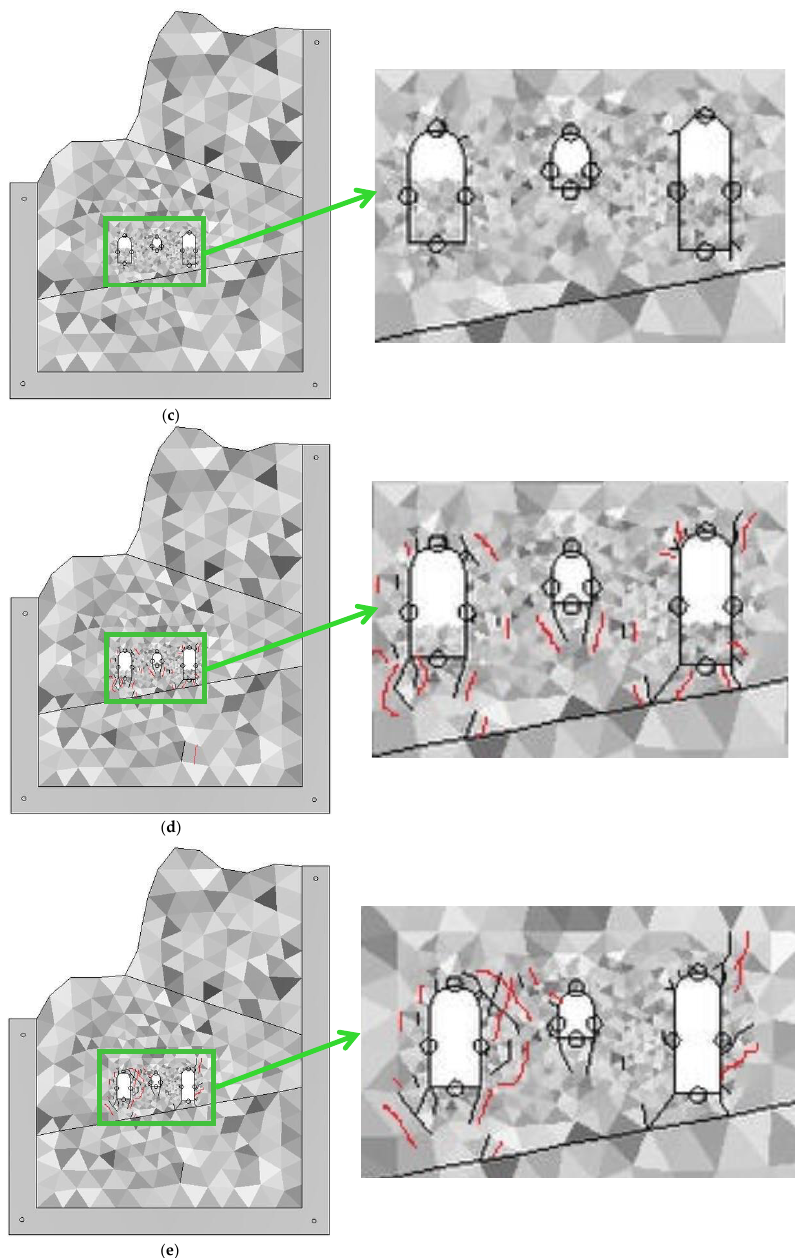
Figure 6. Failure process of SR of the underground cavern group during excavation in Scheme 2: ( a ) The excavation began; ( b ) the 1st step of excavation is completed; ( c ) the 2nd step of excavation is completed; ( d ) the 3rd step of excavation is completed; ( e ) the 4th step of excavation is completed.